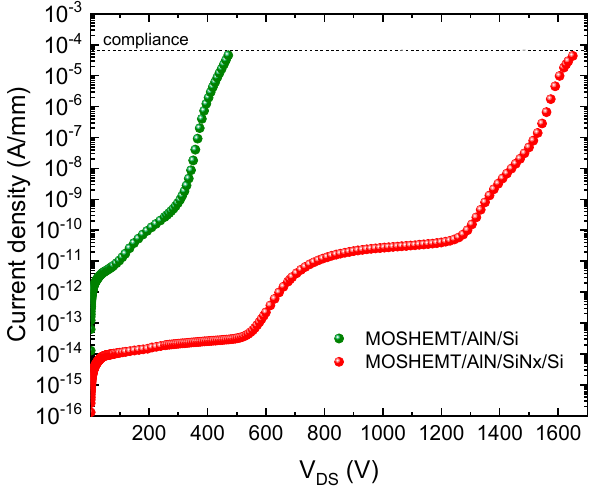
Figure 9. Drain current Vs drain voltage of MOS-HEMT with (V BD = 1500 V) and without SiNx interlayer (V BD = 500 V).